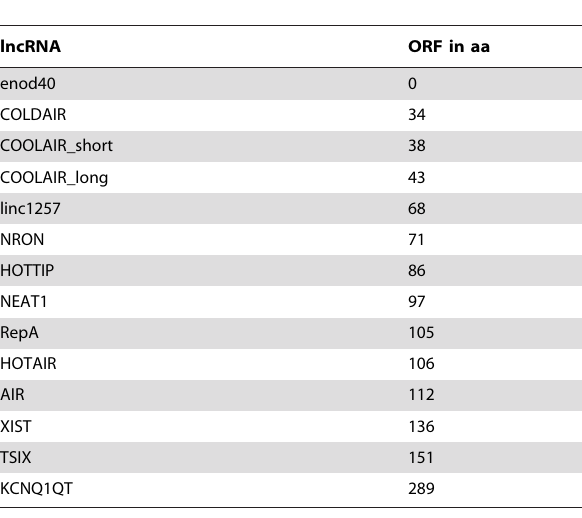
Table 1. Known lncRNAs with ORF size in amino